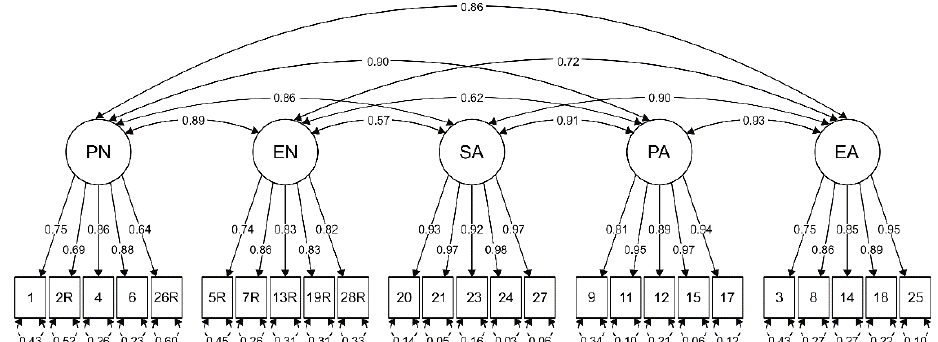
Figure 1. Structural equation modeling (SEM) path diagram of the CTQ scale with items distributed into five standard subscales.